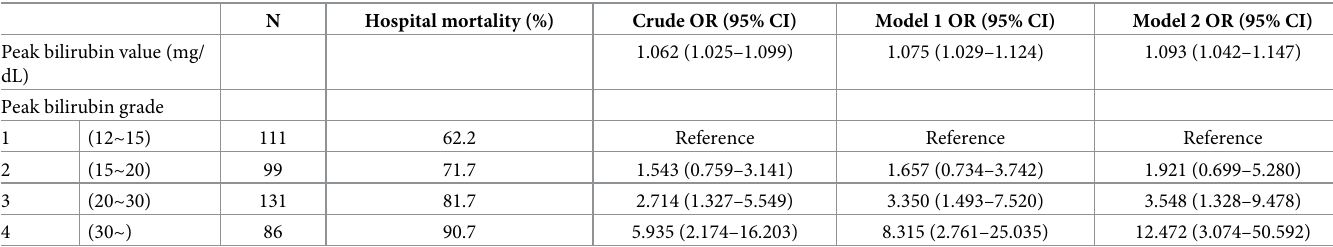
Table 3. Odds ratios for mortality according to the peak bilirubin level.